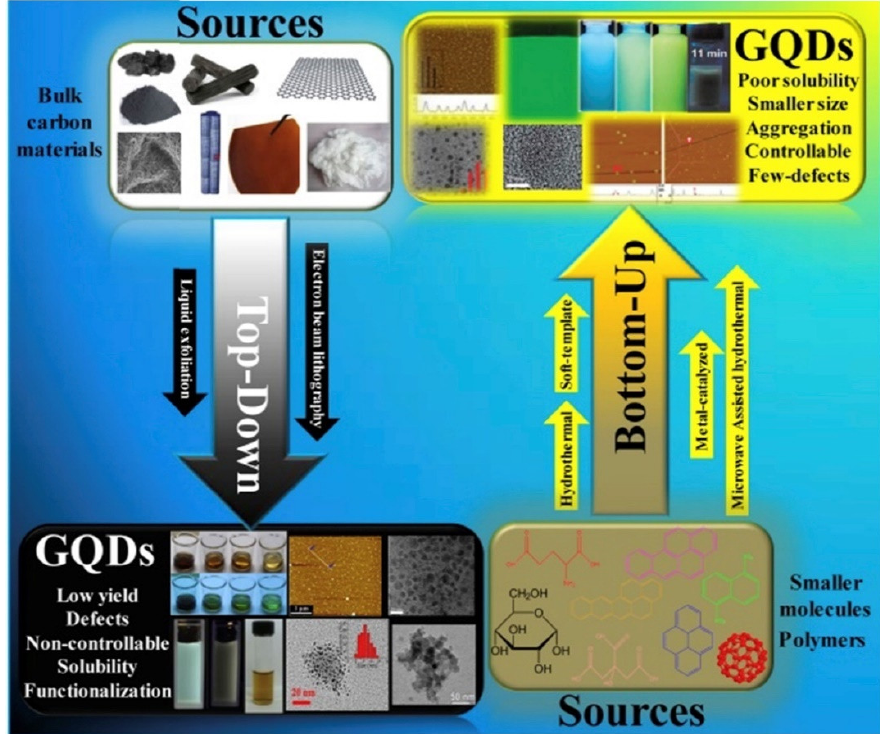
Figure 5. Scheme of graphene quantum dots (GQDs) top–down and bottom–up approaches as reported by [169] (under CC license).